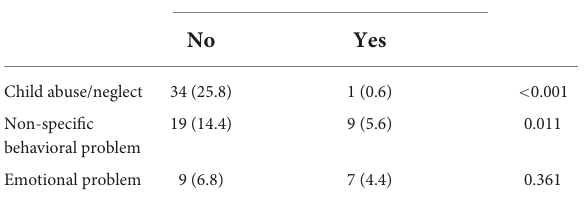
TABLE 4 Children outcomes in relation to maternal abstinence from drug use for up to 2-year post-delivery. Maternal abstinence from drug use up to 2 years post-delivery*